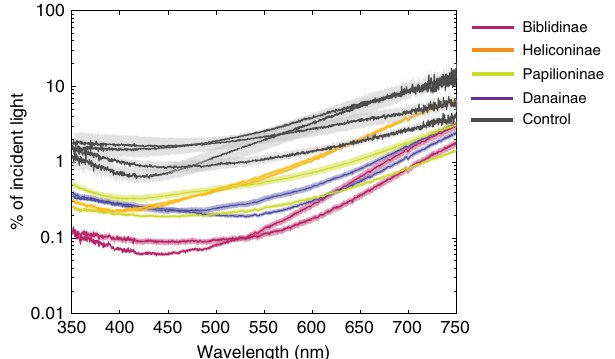
Fig. 1 Re fl ectance of ultra-black and control butter fl ies. Re fl ectance ( + / − 1 SE; n = 3 – 5 depending on the species) from 11 ultra-black butter fl ies from fi ve subfamilies. Note the logarithmic scale for re fl ectance ( y